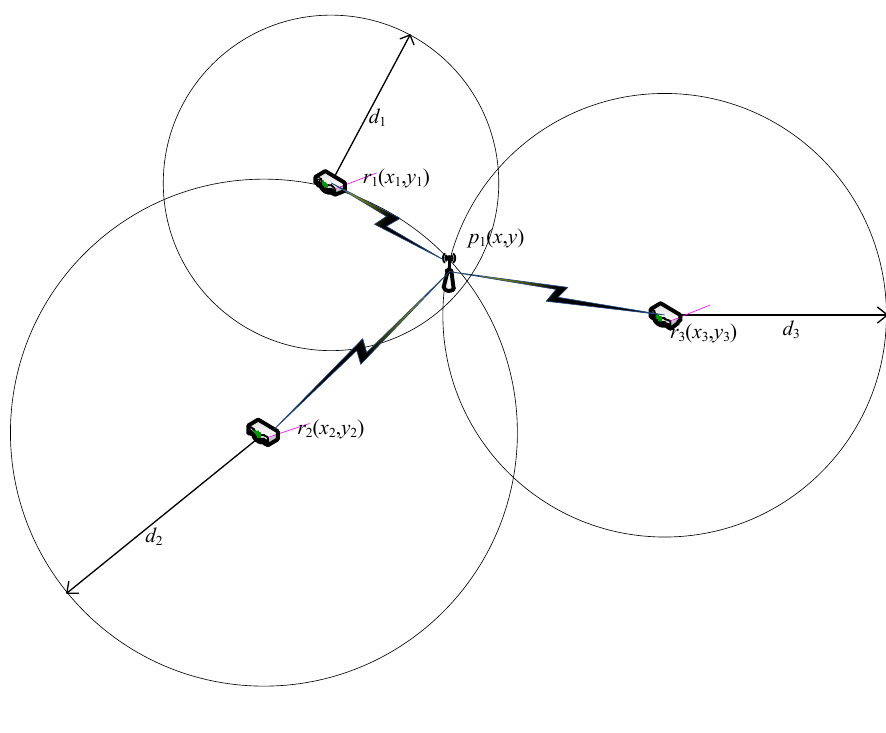
Figure 7. The schematic of